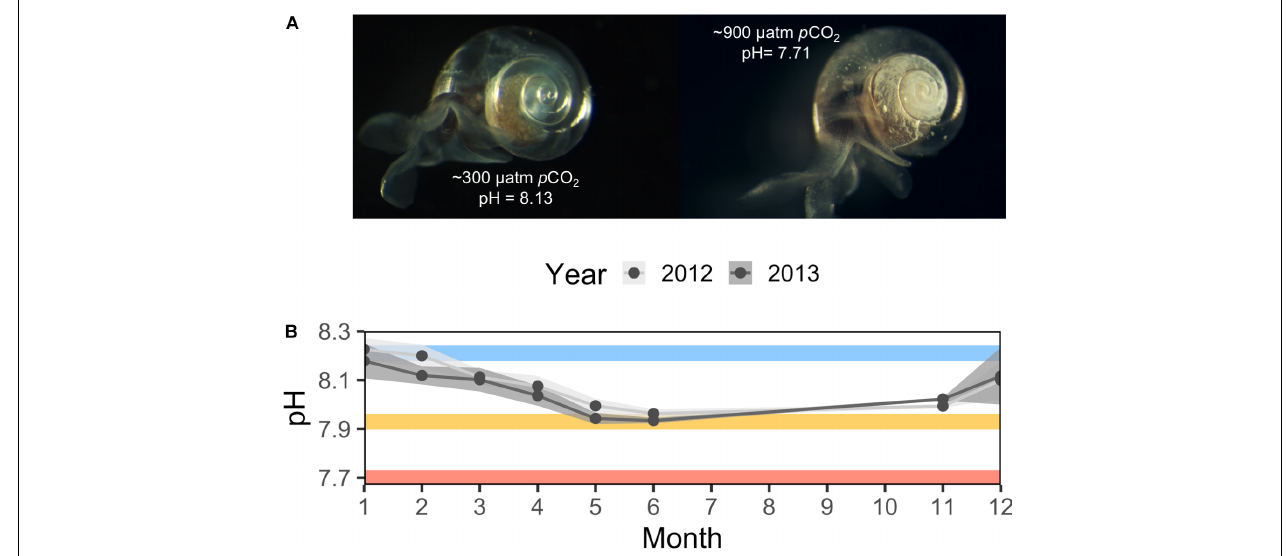
FIGURE 1 | In situ and experimental ocean acidification experienced by Limacina helicina antarctica . (A) Representative images of shell dissolution following exposure to ∼ 300 and ∼ 900 µ atm p CO 2 for 14 days. (B) Mean surface ocean pH recordings per month from McMurdo Sound taken at McMurdo Station circa 2012 and Cape Evans circa 2013 recorded by Kapsenberg et al., 2015 and Hoshijima et al. (unpublished). Error windows represent ± SD. Mean pH from 255, 530, and 918 µ atm p CO 2 experimental conditions are subimposed as blue, yellow, and red lines, respectively.